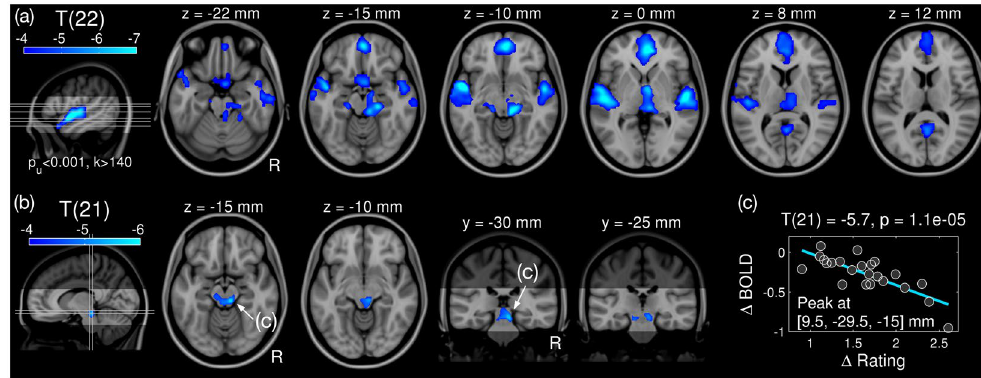
Figure 2. Effect of dissonance in functional activation. ( a ) T-map (d.f. = 22) for the effect of dissonance is shown in axial slices with MNI152 coordinates above each slice. Locations of axial slices are marked as a grey line in the left most sagittal slice. Anatomical image is shaded to highlight the actual slab of fMRI scans. ( b ) T-map (d.f. = 21) for intersubject correlation between the BOLD contrast and rating contrast. Axial and coronal slices are shown also with coordinates. ( c ) Scatterplot of BOLD contrast over rating contrast with a regression line (cyan) at the peak voxel (marked by arrows in ( b ) z = − 15 mm; y = − 30 mm) for the intersubject correlation. Family-wise error rate (FWER) was controlled to be less than 0.05 by cluster-extent thresholding. Abbreviation: d.f., degrees of